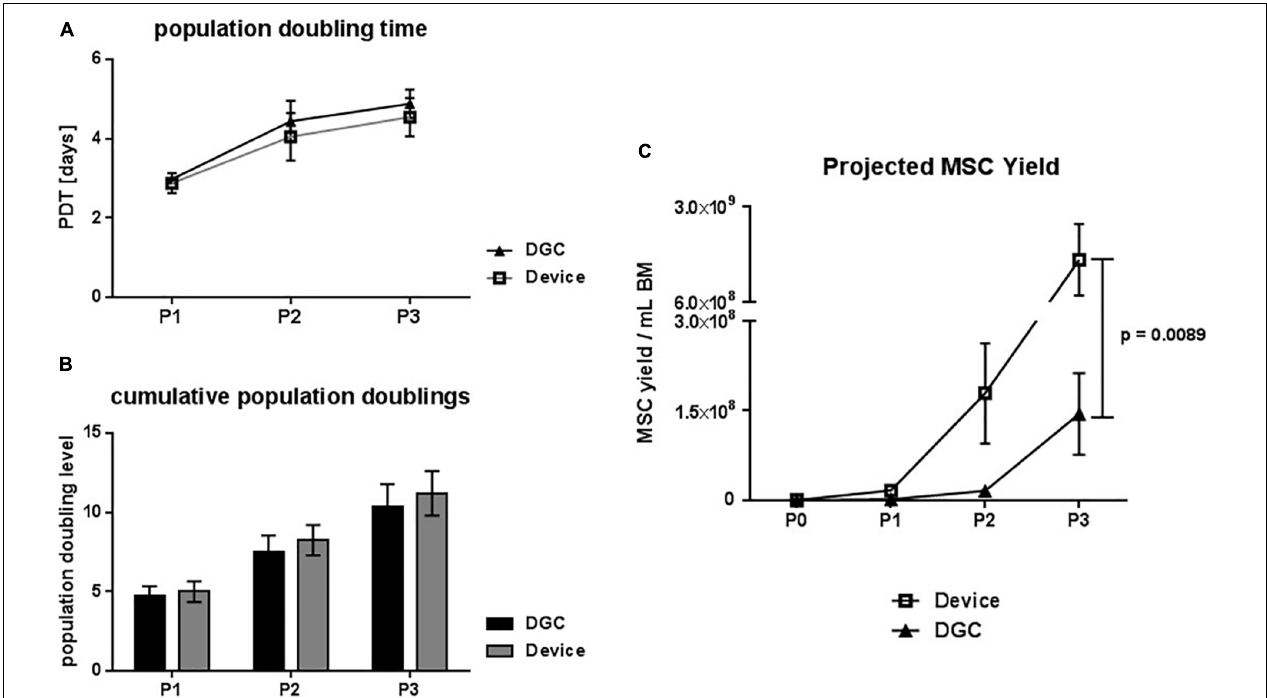
FIGURE 3 | Growth kinetics. Population doubling time (PDT) in days (A) and cumulative population doublings (B) at passage (P) 1, 2, and 3. Projected MSC yield at P1–3 per mL collected BM (C) . Data are presented as means ( n = 5 donors). Error bars: SEM. Two-way ANOVA. P -values are only shown for statistically significant